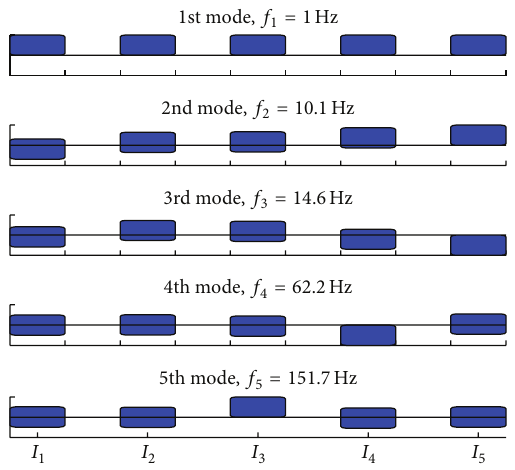
Figure 4: Natural frequencies and mode shapes computed from the simulation model.